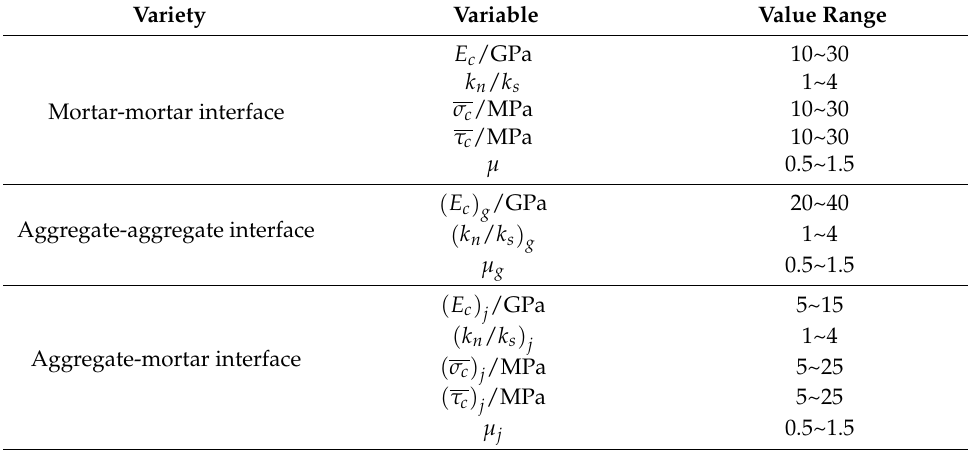
Table 4. Research interval of microparameters.